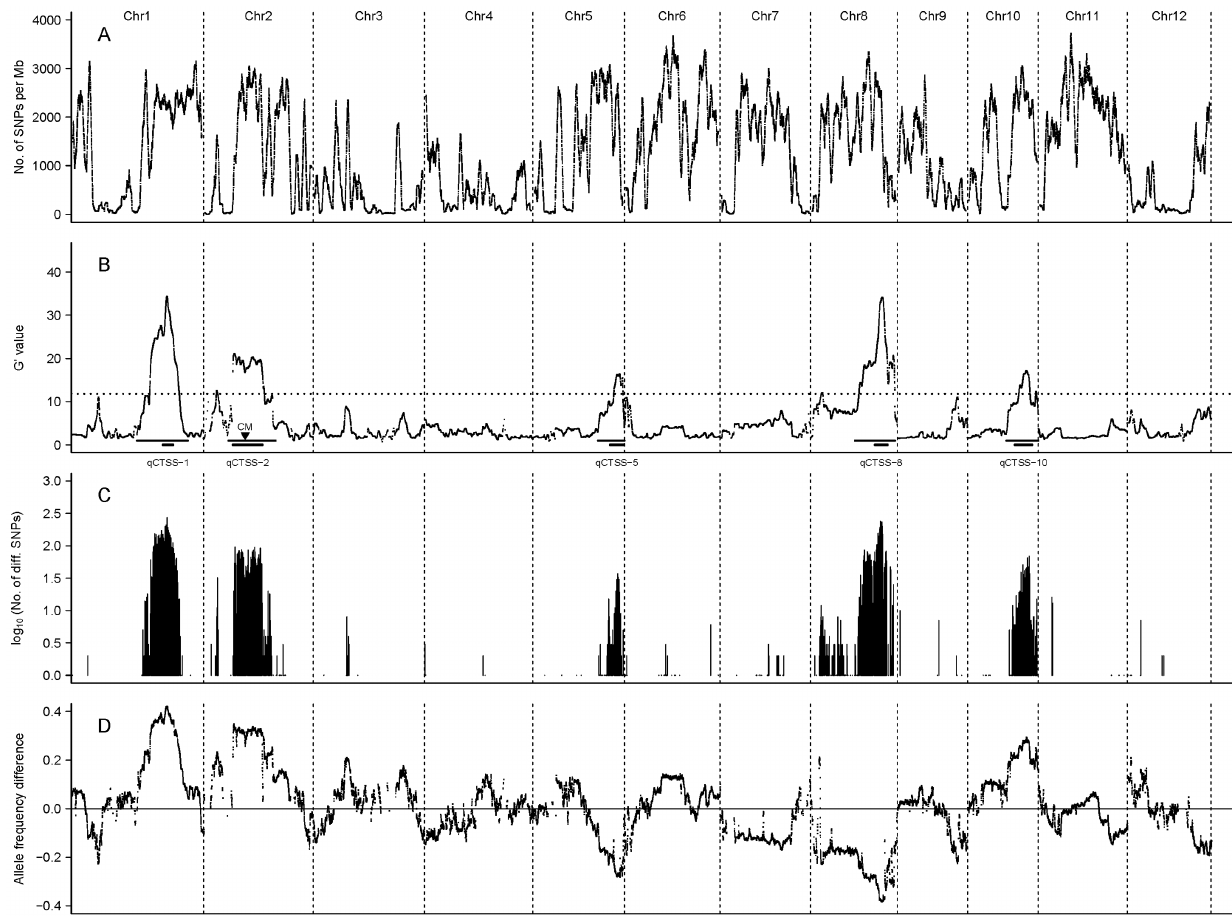
Figure 1. Statistical difference between the two pools along the genome revealed by three methods. A: SNP distribution in the genome. B: G 9 value profile. The horizontal dotted line shows the significance threshold for FDR # 0.05. The upper longer and lower shorter horizontal bars under each major G 9 peak indicate the ranges of the full and the most probable intervals of a putative QTL, respectively. The downward black arrowhead marked as CM within the interval of qCTSS-2 indicates the position of centromere on chromosome 2. C: Distribution of differential SNPs in the genome. D: Profile of Nipponbare allele frequency difference.